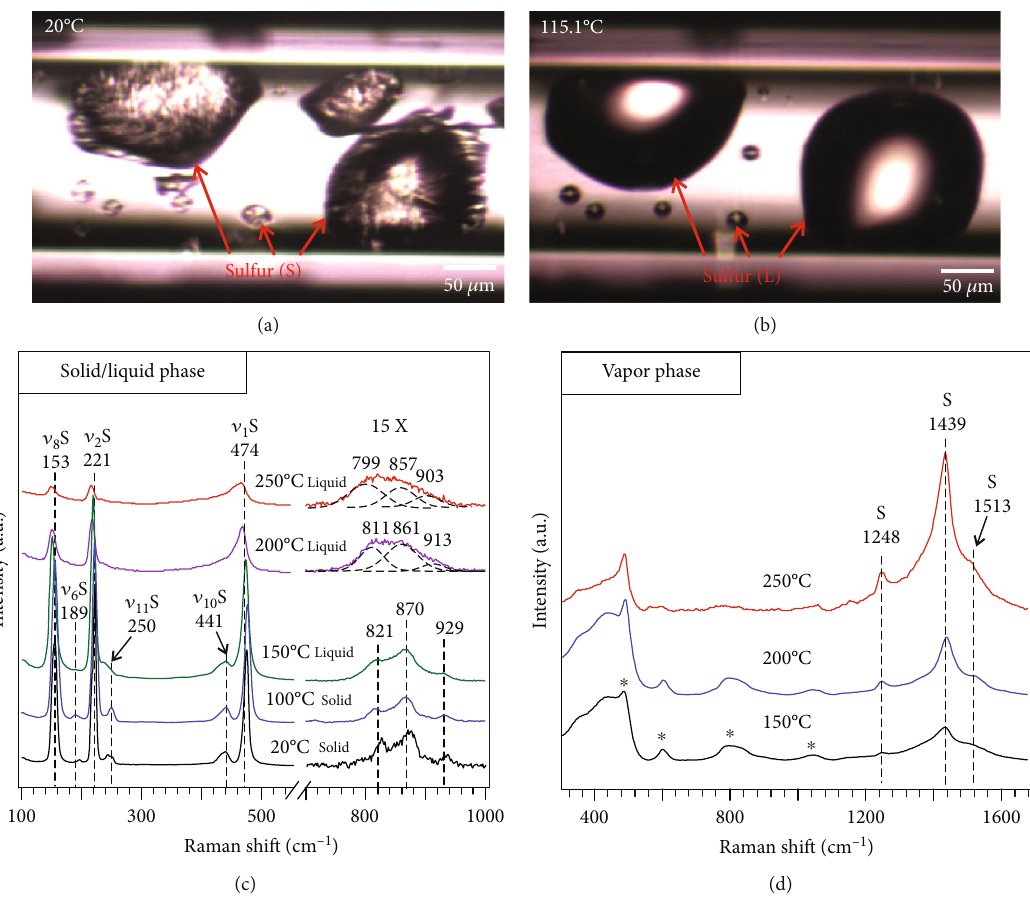
Figure 1: Phase transitions (a and b) and in situ Raman spectra (c and d) of the pure S system. (a) Solid S at 20 ° C; (b) liquid S at 115.1 ° C; (c) spectra of solid and liquid S in the 100 – 1000cm − 1 region at 20 – 250 ° C. The intensities of the spectra in the 700 – 1000 cm − 1 region were multiplied by 15; (d) spectra of the vapor phase at 150 – 250 ° C. Stars denote the background signals of the silica